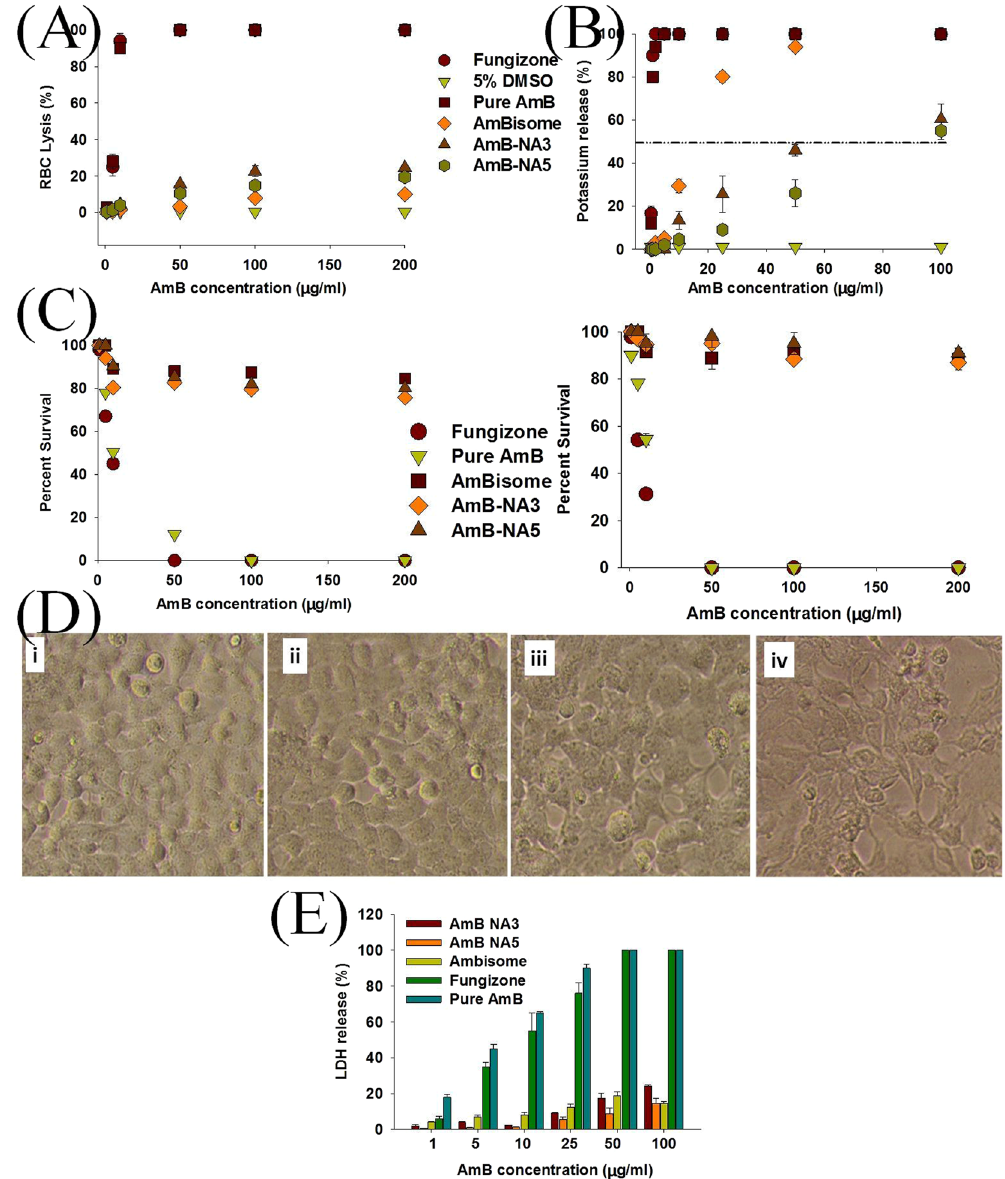
Figure 4. In vitro toxicity tests: ( A ) Hemolysis caused by AmB-NA upon their interaction with human RBCs. The extent of damage incurred to blood erythrocytes by AmB-NA was measured as percentage lysis of total erythrocytes ( B ) Intracellular K + leakage incurred by human RBCs upon exposure to various AmB formulations. ( C ) Dose-response effects of AmB nano-formulation on cytotoxicity against (a) HEK-293cells (b) J774A.1 cells. The cells were exposed to two forms of AmB-NA for 24 hr. MTT values were normalized to the control untreated cells. Data are reported as means ± standard deviation of quadruplet. Fungizone, AmBisome and pure AmB were taken as controls. ( D ) Representative photomicrograph of J774A.1 cell line treated with (i) 25 µ g/mL, (ii) 50 µ g/mL, (iii) 100 µ g/mL and (iv) 200 µ g/mL concentration of AmB-NA for 24 hr. ( E ) LDH release induced by various AmB formulations, as a function of membrane damage in macrophage J774 A.1. The LDH release was detected by measuring the absorbance of colored complex at 500 nm. Triton X-100 (0.1%) was used as a positive control. Fungizone, AmBisome and pure AmB powder used in preparation of the complex were taken as controls. Data represented are pooled from three different experiments. Each data point is an average ± SD. Aloe vera leaf extract showed no change in any of the parameters tested (data not